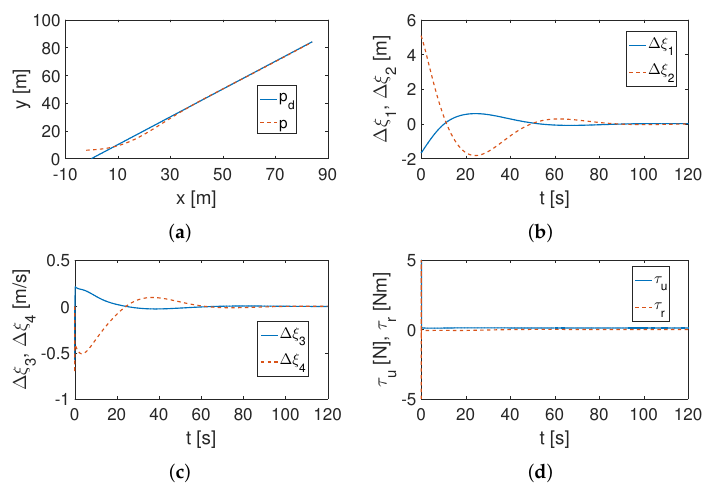
Figure 3. Simulation results for ROPOS original controller (CL) and linear trajectory: ( a ) desired and realized trajectory; ( b ) position error states; ( c ) velocity error states; ( d ) applied force and